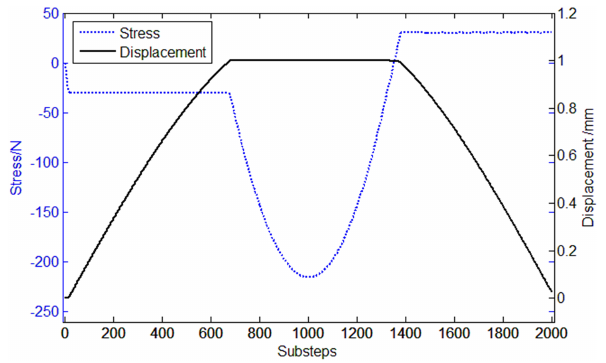
Figure 7. Displacement curve of component